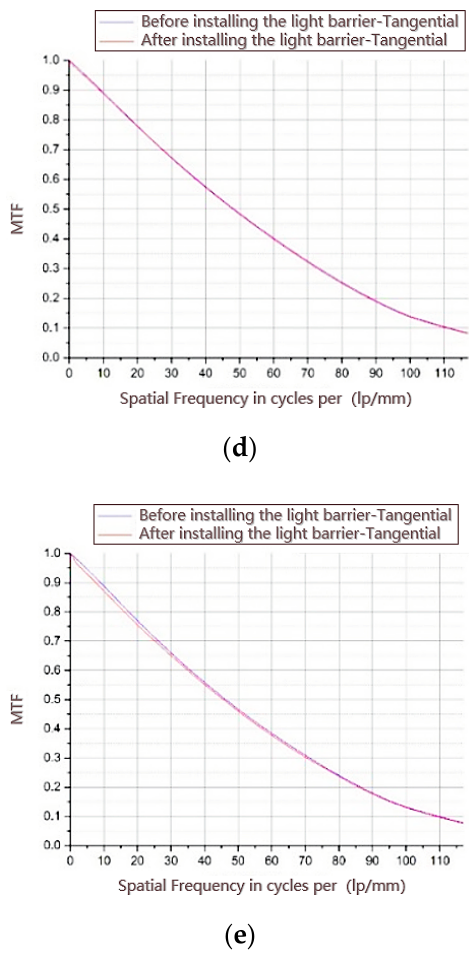
Figure 12. Simulation results of the modulation transfer function (MTF). ( a ) MTF curve in the tangential direction with a field of (0, − 5.05°); ( b ) MTF curve in the tangential direction with a field of (0, − 4.7°); ( c ) MTF curve in the tangential direction with a field of (0, − 5.4°); ( d ) MTF curve in the tangential direction with a field of (4°, − 5.05°); ( e ) MTF curve in the tangential direction with a field of (8.05°, − 4.7°).